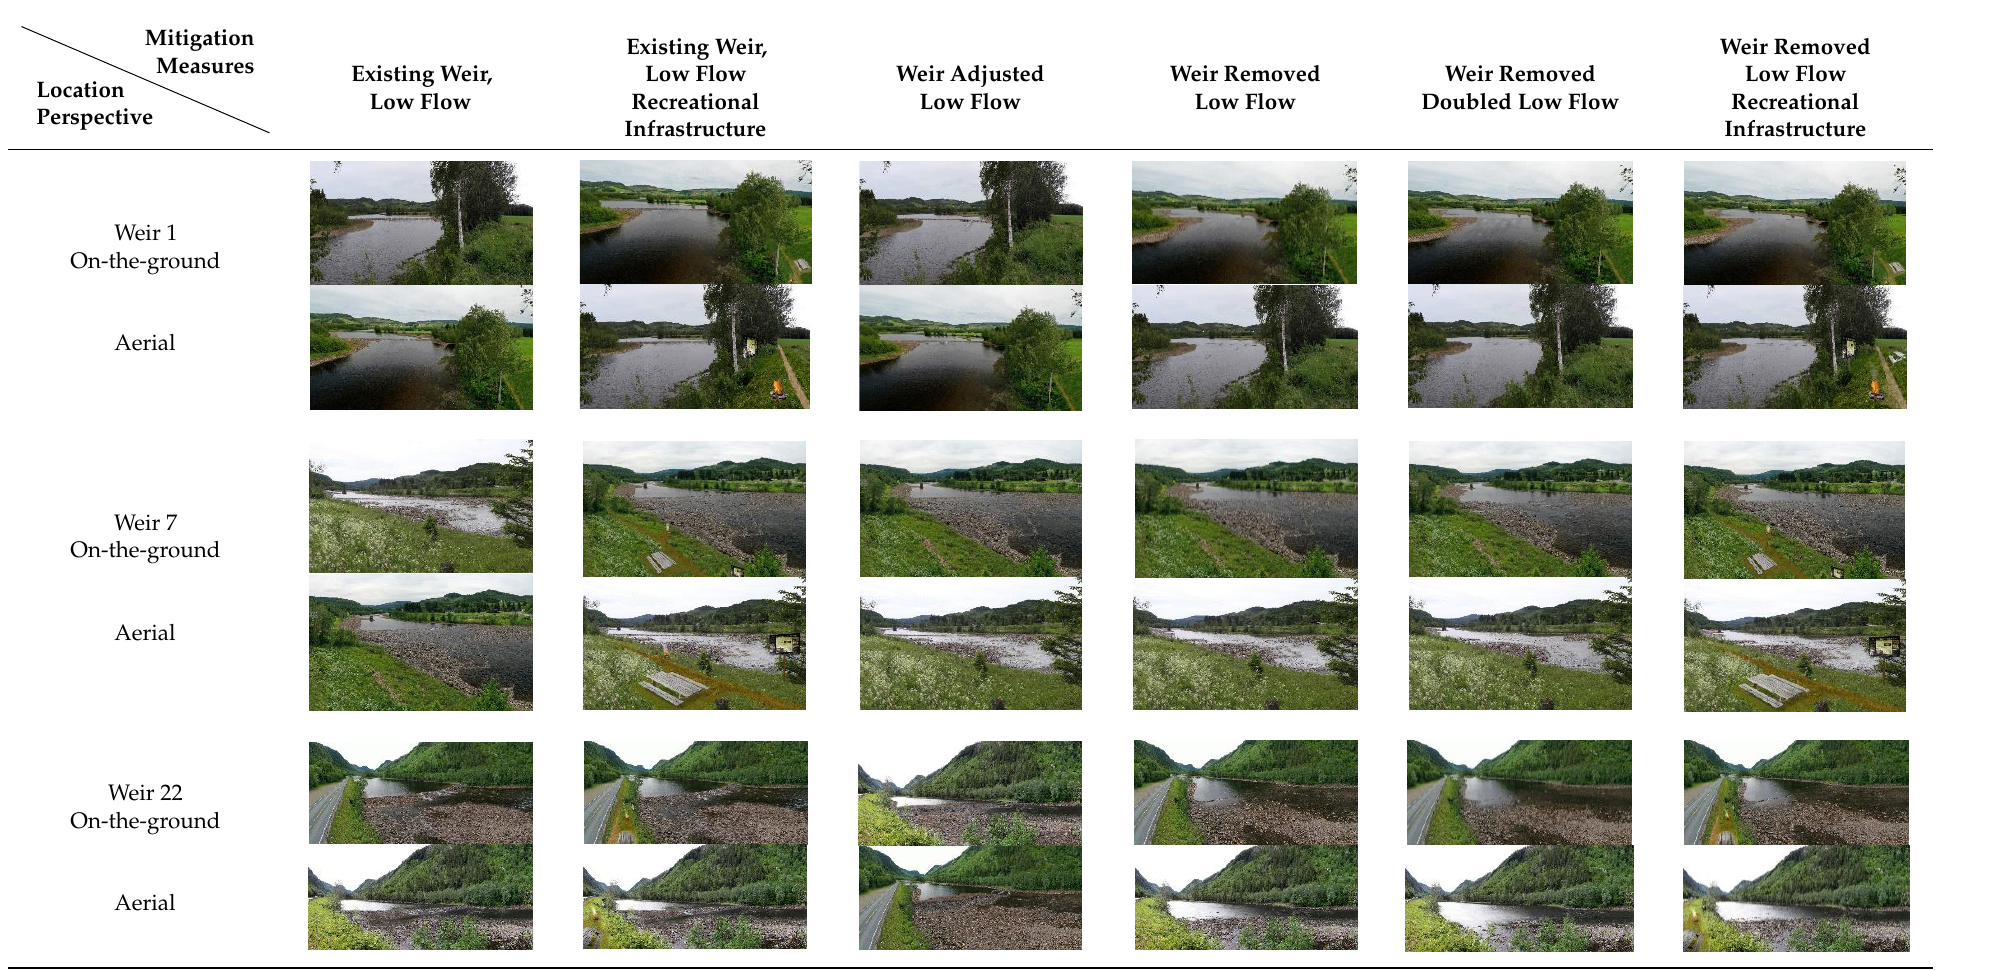
Table 3. Visual scenarios of environmental measures.